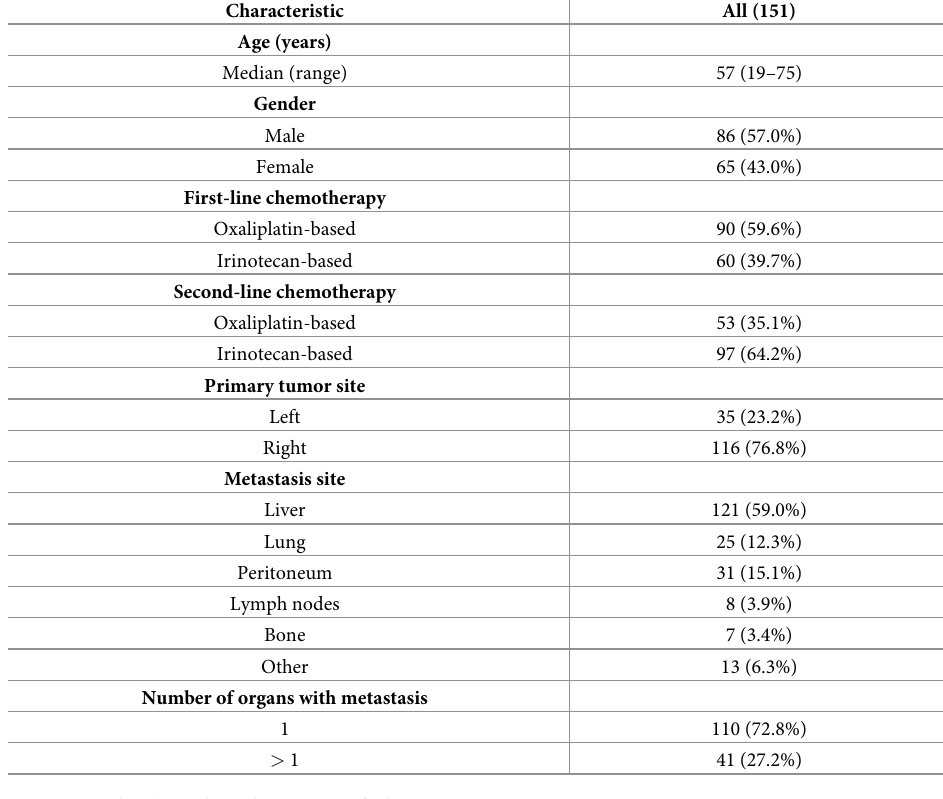
Table 1. Baseline patient